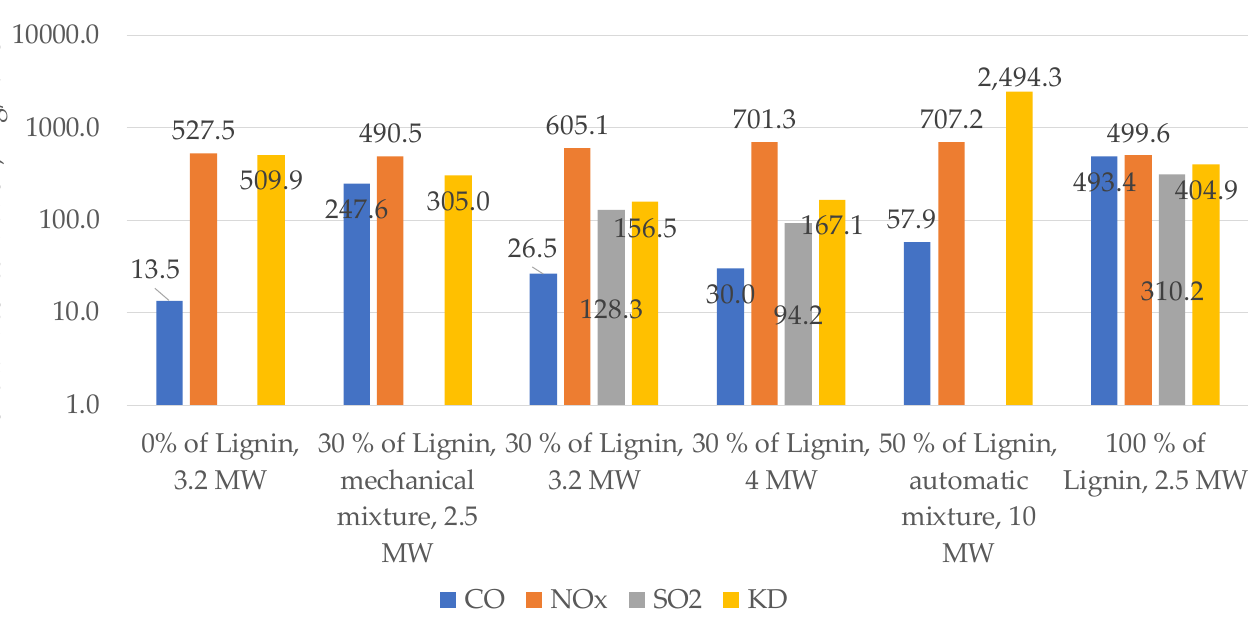
Figure 3. Concentrations of pollutants emitted with different shares of lignin in the burnt fuel under varying power of the boiler in combustion mode.